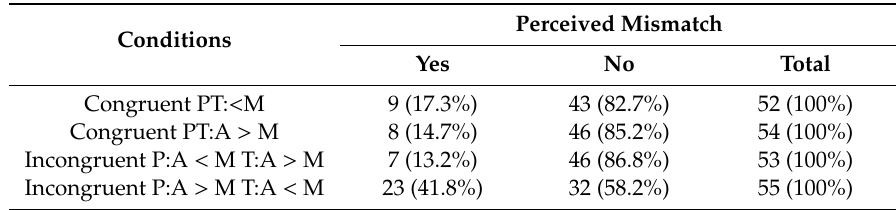
Table 5. Count and proportion (%) of perceived mismatch amongst (in)congruent conditions in pre-consumption